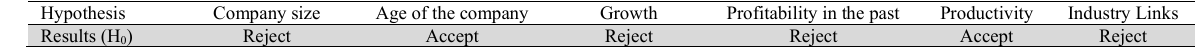
Summary of the results of multivariate regressions